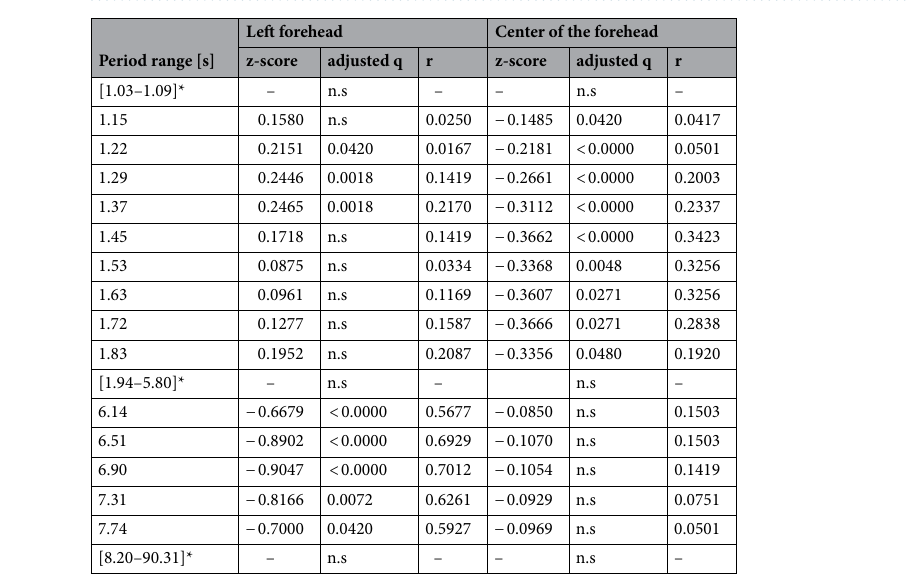
Table 2. Results of permutation test on the average WTC values for each measurement channel and condition. Adjusted q indicates statistical significance corrected for multiple comparisons with false-discovery rate; and, r indicates an effect size calculated using Wilcoxon signed-rank test. *: Period ranges [1.03–1.09], [1.94–5.80], and [8.20–90.31] includes 2, 20, and 44 period ranges of different duration, respectively.